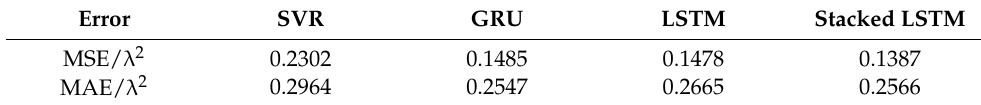
Table 3. Mean square error and mean absolute error of astmag on different modules.